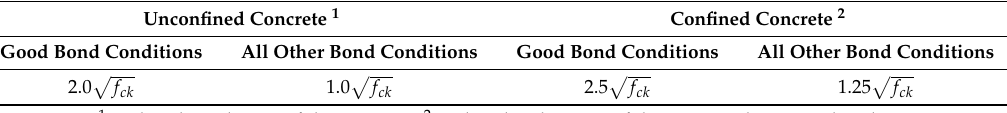
Table 6. Parameters for defining mean bond strength (CEB-FIP model code,